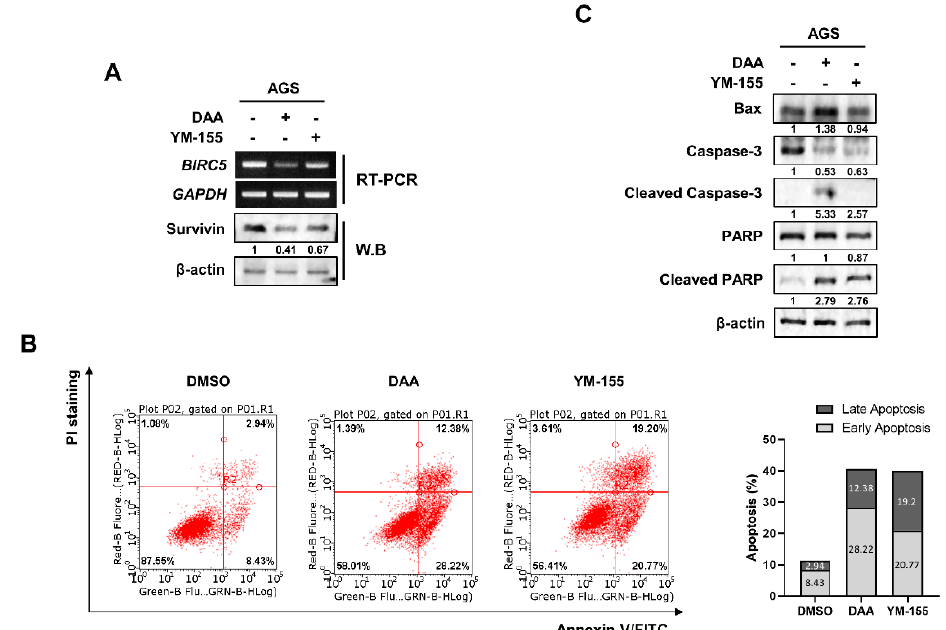
Figure 4. DAA exhibited a better inhibitory effect than survivin inhibitor YM-155. ( A ) AGS cells were treated with 85 µM and 5 nM of DAA and YM-155 for 48 h, respectively, and the expression of survivin was determined by RT-PCR and Western blotting. ( B ) AGS cells were treated with 85 µM and 5 nM of DAA and YM-155 for 48 h, respectively. After annexin V/PI staining, flow cytometry was performed. Bar graph shows the rates of early-stage and late-stage apoptosis. ( C ) AGS cells were treated with DAA and YM-155 for 48 h. Apoptosis-related protein expression was confirmed through Western blotting.